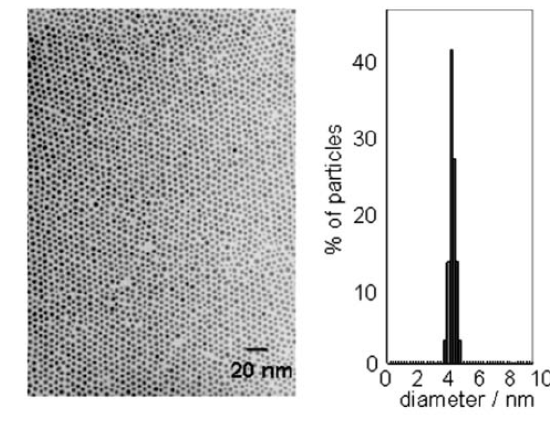
Figure 6. TEM picture of very small and monodisperse Ag NPs synthesized through the thermolysis of [Ag(C (left) and size histogram (right) (adapted from [28] with permission of the The Royal Society of